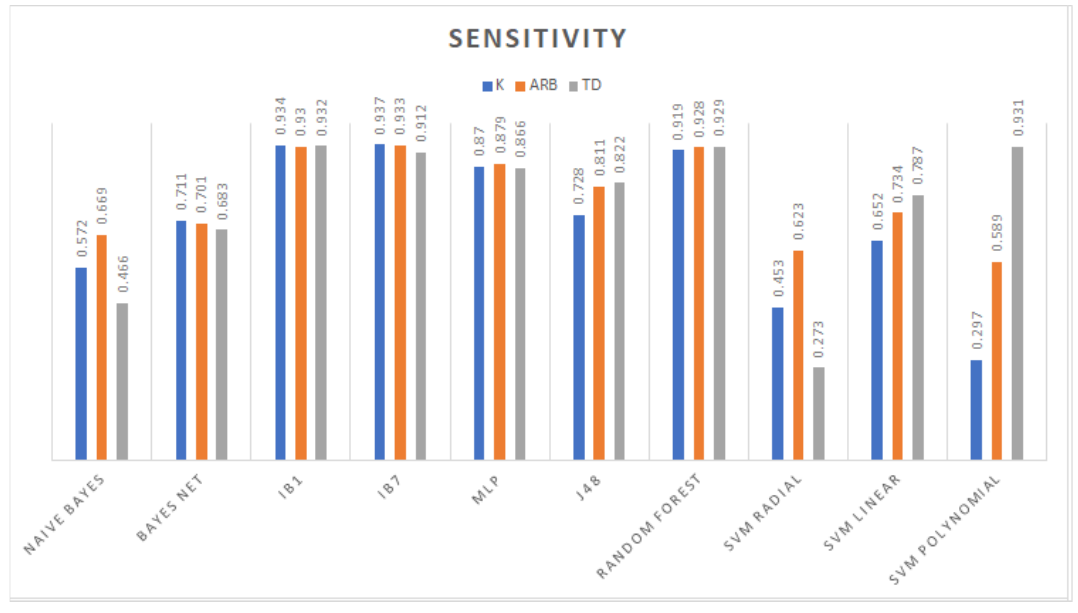
Figure 6. Sensitivity achieved by the different classifiers.